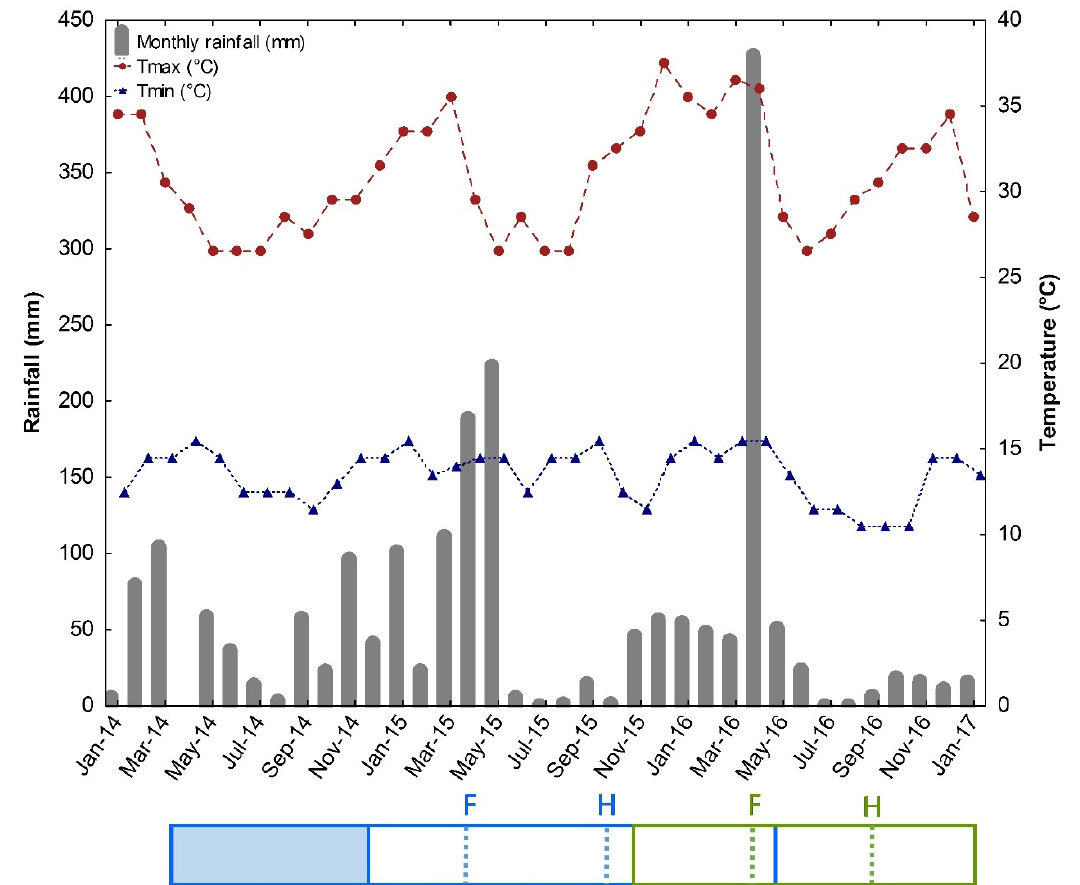
Figure 2. Monthly rainfall and minimum–maximum temperatures recorded from January 2014 to January 2017, which includes the field trial period, and the corresponding phenology. The blue-shaded area corresponds to the pre-flowering (vegetative) phase and the clear (unshaded) area corresponds to the maturity phase (flowering and harvest). F and H indicate average flowering and harvesting times, respectively, for the four Musa genotypes in both treatments (irrigated and rain-fed). Blue: first crop cycle; green: second crop cycle. Due to a technicality, rainfall data could not be recorded from 1 April to 10 May 2014.